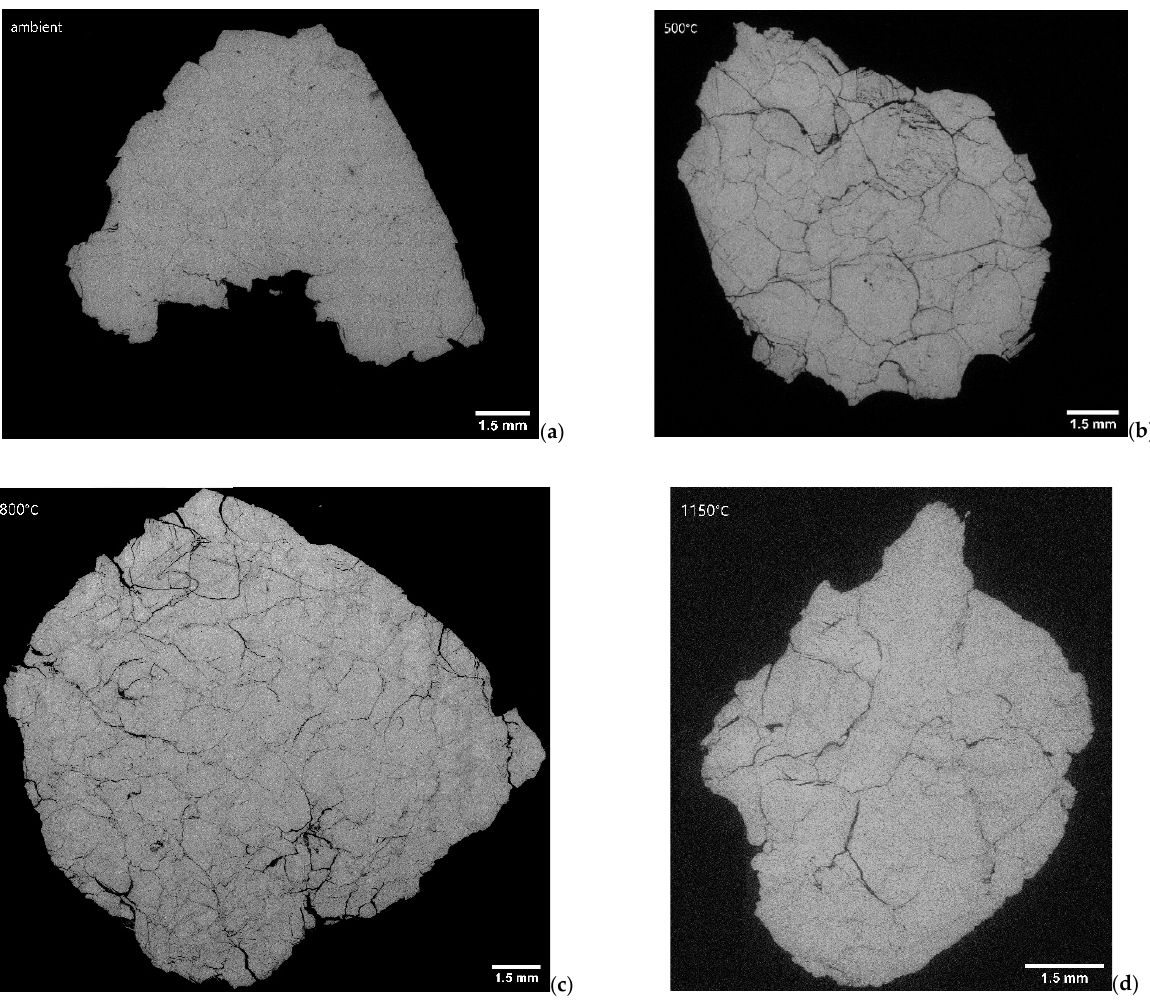
Figure 5. SEM images of limestone and quicklimes of sample 74 (TD = 4%). ( a ) Limestone at ambient temperature, ( b ) heated to 500°C, ( c ) heated to 800°C, and ( d ) heated to 1150°C.